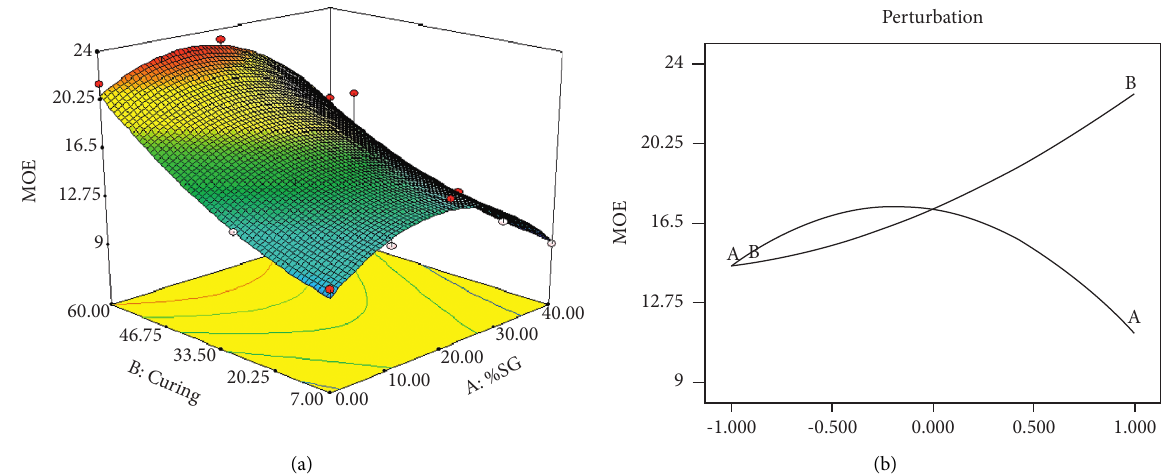
Figure 16: Response surface plots (a) and perturbation plots (b) indicating the relationship between spent garnet content and curing days with respect to modulus of elasticity (MOE).